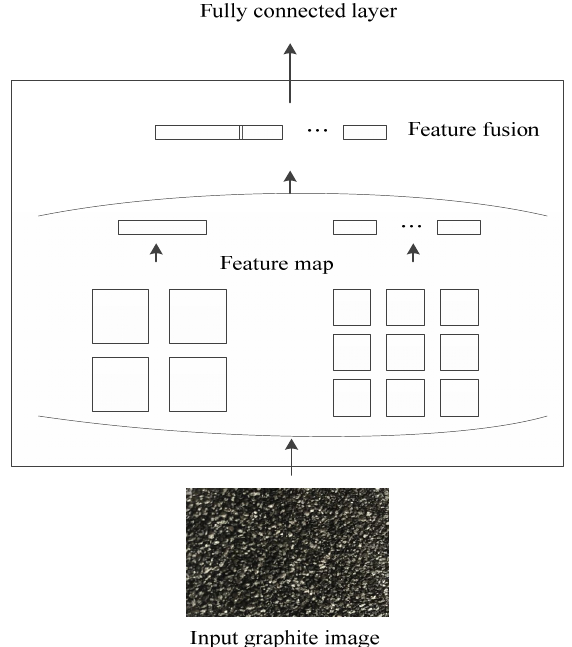
Figure 6. The fusion mechanism of this paper.